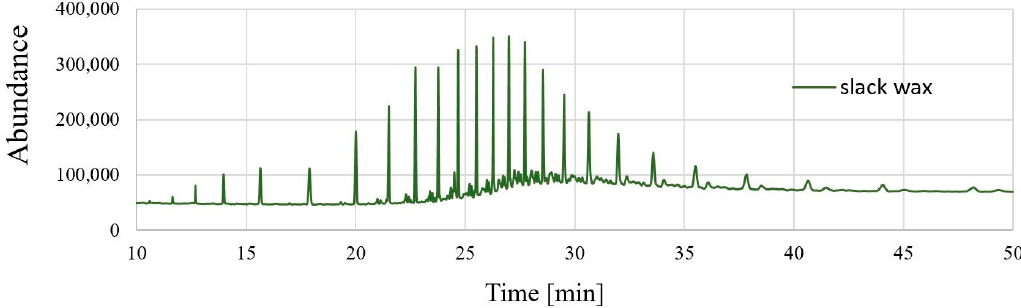
Figure 3. Chromatograms of slack wax.